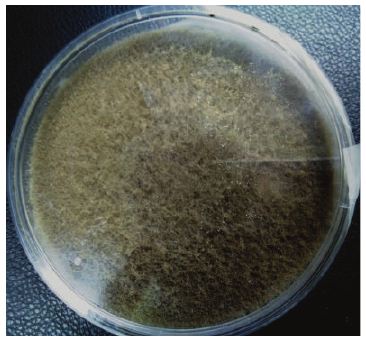
Figure 4: Mature growth on SDA after 72